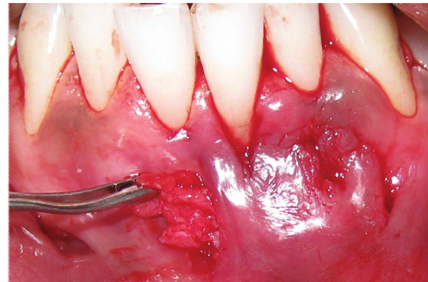
Figure 4: Placement of the connective tissue graft in the prepared tunnel.